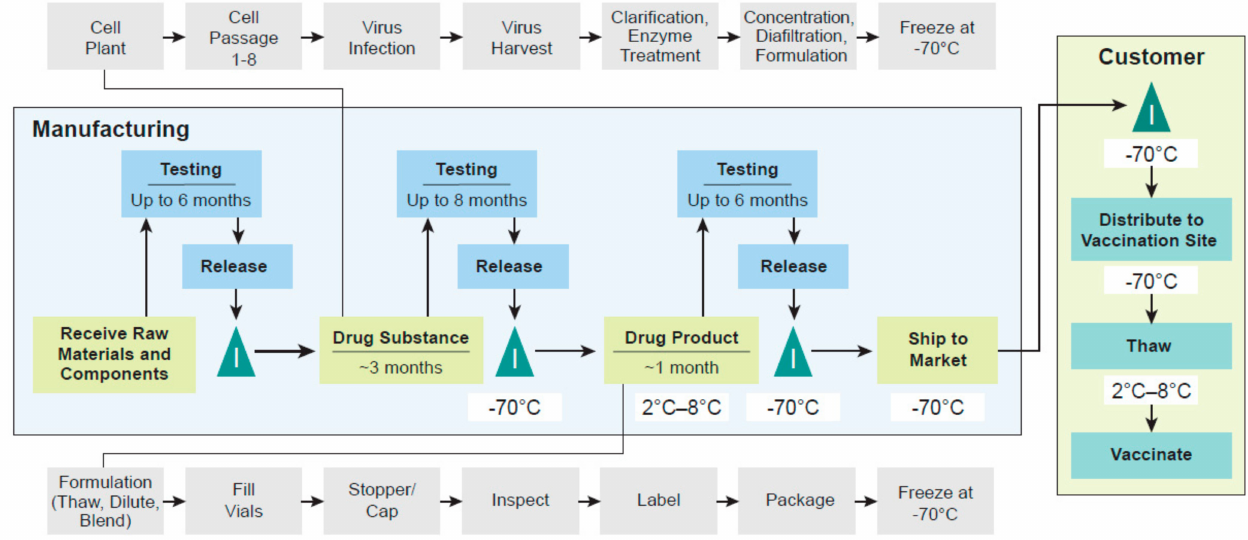
Figure 2. End-to-end steps for vaccine manufacturing and supply. The manufacture of a vaccine requires the completion of a sequence of activities starting from the receipt of raw materials and components through the release of a dose that is ready to be administered to a patient. At different steps of the process, inventory (I) may be held until the completion of the preceding